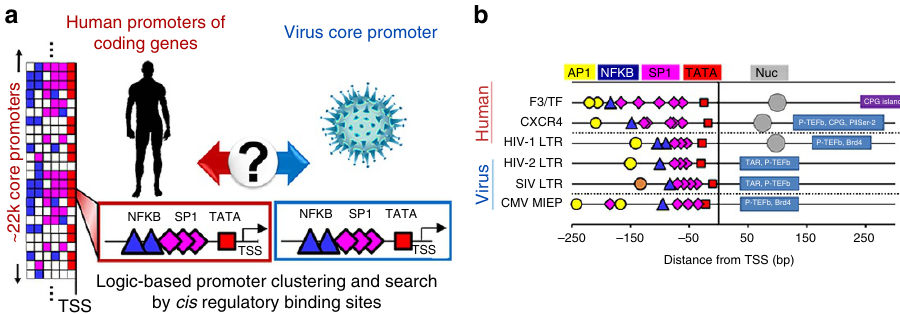
Figure 1 | Viral and host promoters display high similarity in gene regulatory sequence. ( a ) Logic-based search of human coding gene promoters for similarity to viral core promoters. The list of human promoters indicates a logic series of cis -binding elements (boxes) for each promoter (rows) comprising diverse patterns of TATA box (red), SP1 (pink) and NFKB (blue) binding sites. Conserved cis -binding sites in a virus (NFKB: blue triangles, SP1: pink diamonds and TATA: red squares) are searched for in all human coding genes. HIV and CMV promoters are curated and compared within ± 250bp from the TSS of human promoters. Promoters are clustered regardless of number, arrangement or distance of sites from the TSS. Additional transcription factor- binding site types are ignored to de-constrain results of the search. ( b ) The genome-wide promoter search results in B 366 gene promoters with binding sites for TBP (TATA-binding protein, red squares), SP1 (pink diamonds) and NFKB (blue triangles), and F3/TF, CXCR4 and HIV-1 LTR show the highest similarity in cis regulatory arrangement. Upstream existence of AP1 sites (yellow circles) and downstream nucleosome occupancy (grey circles), binding of P-TEFb (ref. 69), BRD4 (ref. 69) and CPG islands (purple and navy rectangle regions) from the TSS are also consistent between promoters and curated after the initial genome-wide search. The brown circle in the SIV LTR promoter represents simian factor 1 or SF1, an activator protein 1 (AP1) related transcription factor in monkeys reported in SIV around (cid:2) 135 to (cid:2) 131bp 76 .